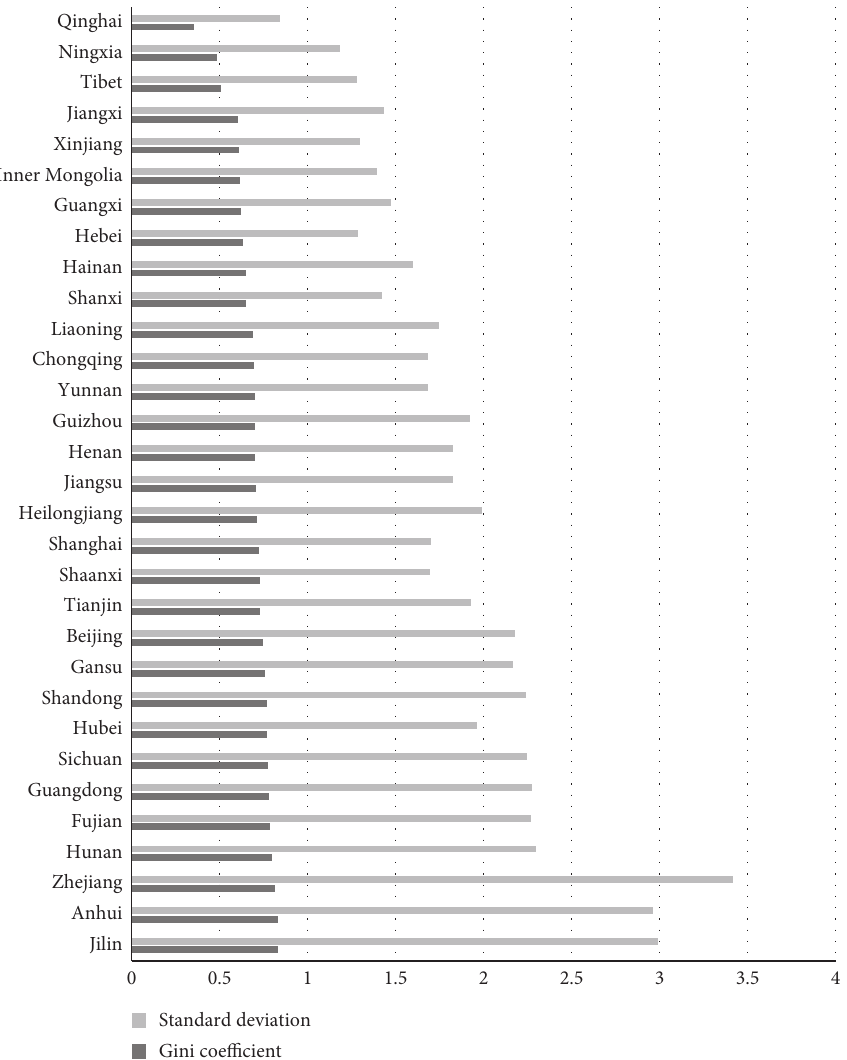
Figure 2: Difference coefficients of the quality of universities in the provinces, provincial-level cities, and autonomous regions on the Chinese mainland. Note. In this figure, rankings are made according to the Gini Coefficients of the scores. Data source: http://www.cuaa.net/ . In terms of data calculation, the result is the average value in five